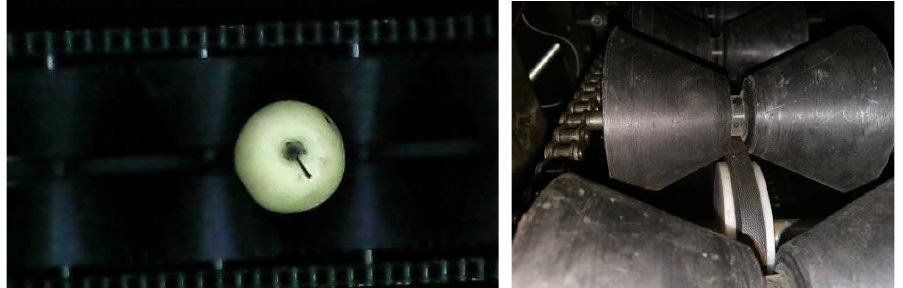
Figure 2. Biconical roller conveyor used for conveying apples in the locally made apple sorting ma- chine (top and front view) . machine (top and front